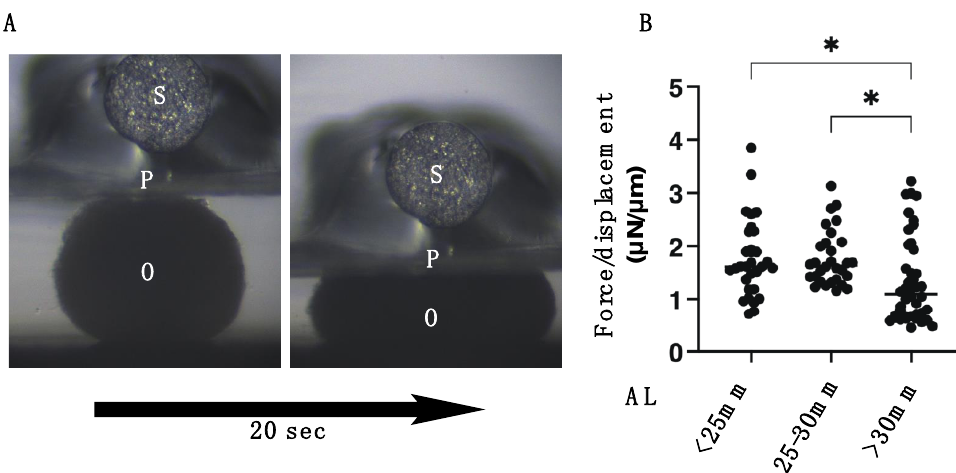
Figure 2. Physical solidity of the 3D spheroids of human scleral stroma fibroblasts (HSSFs). For the measuring the physical stiffness of the 3D HSSF spheroids, a micro-squeezer analysis was used, as shown in panel A (O: 3D sphenoid, P: compressing plate, S: pressure sensor). Among three different ALs, <25 mm, 25–30 mm, or >30 mm, each living 3D HSSFs sphenoid at Day 5 ( n = 20–30) was compressed to induce a 50% deformity during a period of 20 s. The force required (μN) to accomplish this was measured, and the resulting force/displacement (μN/μm) values were plotted in panel B . Data are presented as the arithmetic mean ± standard error of the mean (SEM). * p < 0.05 (ANOVA followed by Tukey’s multiple comparison test).